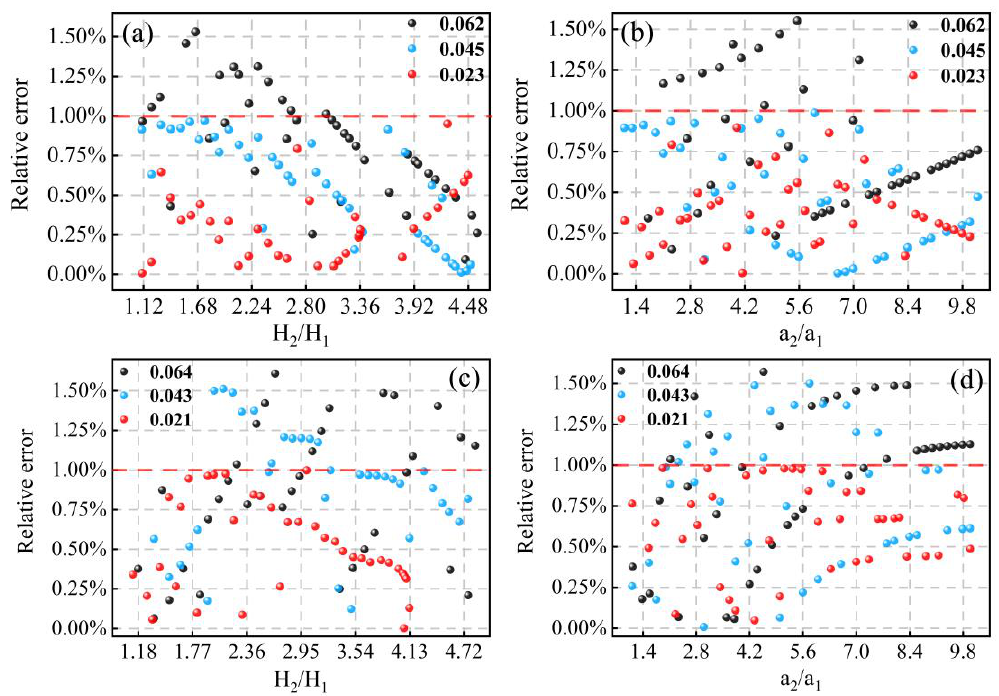
Figure 4. Relative errors of line width for different absorbance of ( a , b ) CH 4 and ( c , d ) CO 2 .